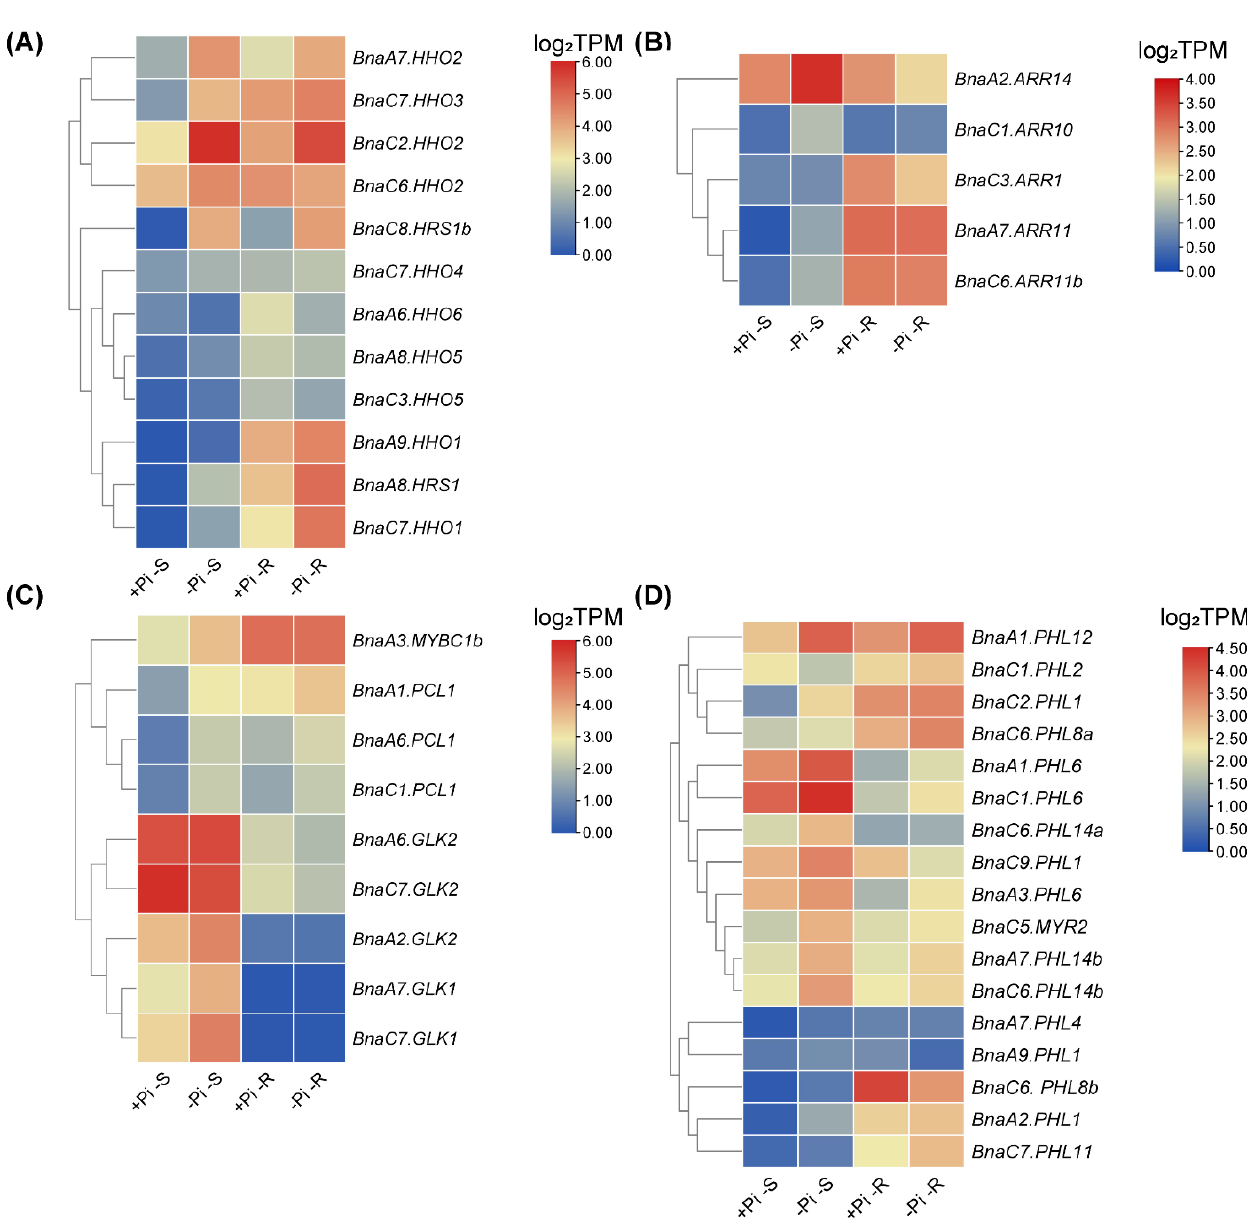
Figure 11. Expression profiles of BnaNIGT1/HRS1/HHOs ( A ), BnaARRs ( B ), BnaGLKs ( C ), and BnaPHLs ( D ) in the shoots/S and roots/R under different phosphate (Pi) levels. conditions. +Pi, high Pi (250 µ M); -Pi, low Pi (5 µ M), The expression levels are normalized by log 2 (TPM). TPM, transcripts per million (reads). The color scales represent relative expression levels from high (red color) to low (blue color).